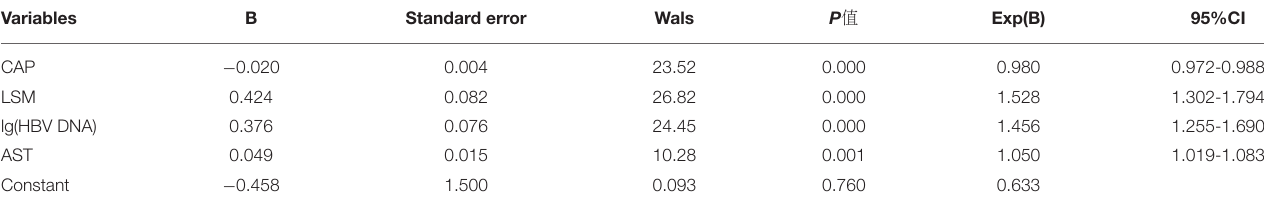
TABLE 3 | The logistic regression analysis of HBV-related inflammation in CBI patients with concurrent NAFLD.